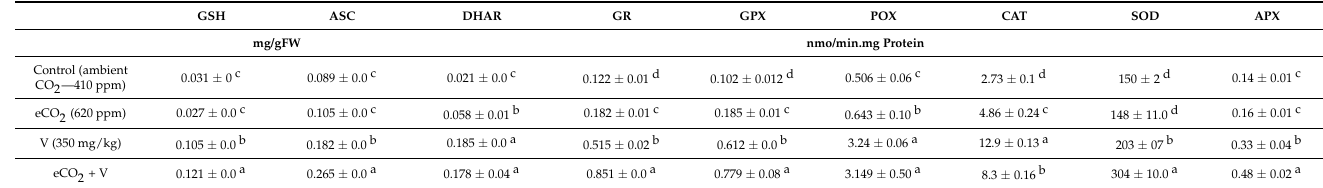
Table 4. Effect of elevated CO 2 (eCO 2 ), vanadium (V) and their combination (eCO 2 + V) on antioxi- dant parameters of wheat. Reduced glutathione (GSH), ascorbate (ASC), dehydroascorbate reductase (DHAR), glutathione reductase (GR), peroxidase (GPX), peroxidase (POX), peroxidase (POX), catalase (CAT), superoxide dismutase (SOD) and ascorbate peroxid (APX). Data are mean values ± SE ( n = 4). Using Fisher’s LSD test, the data for each group were compared pairwise ( p < 0.05; n = 4). Different letters indicate that there is a significant difference between the